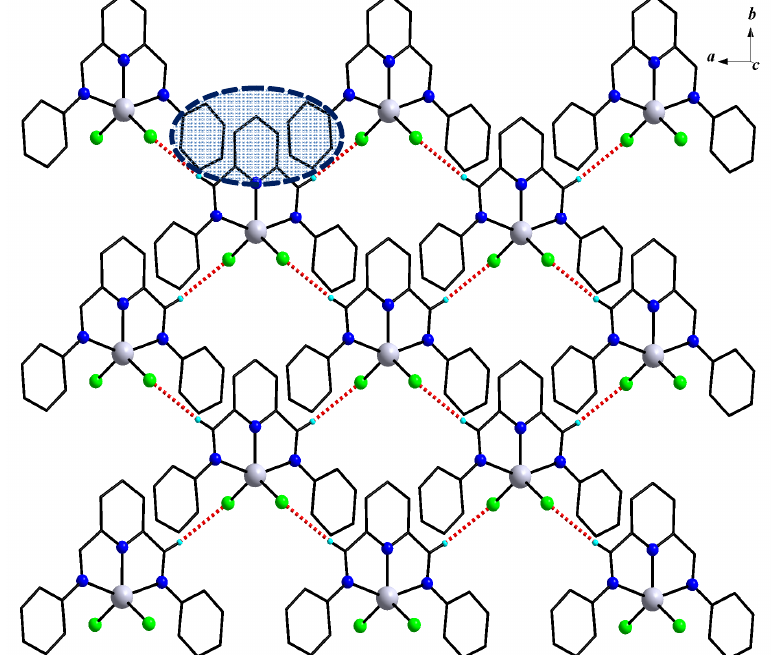
Figure 4. Front view of the 2D supramolecular layer in 4 reinforced by non-conventional hydrogen bonds (2.69 Å) (red dashed lines) and π – π stacking (highlighted by the blue circle). The TTF-(SMe) units were omitted for 2